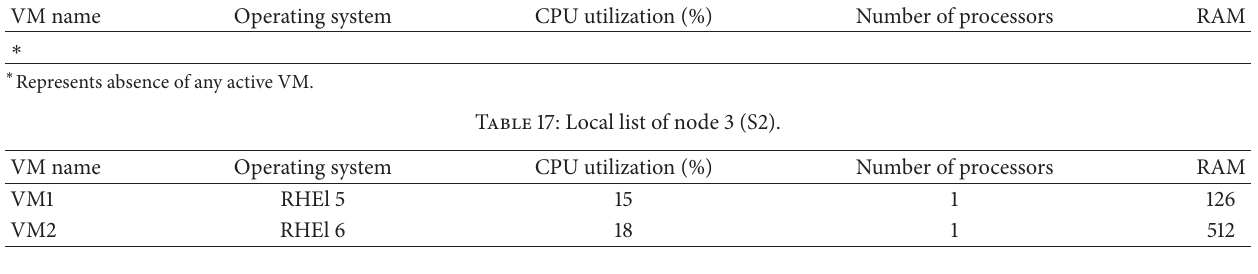
Table 18: Local list of node 4 (S2).